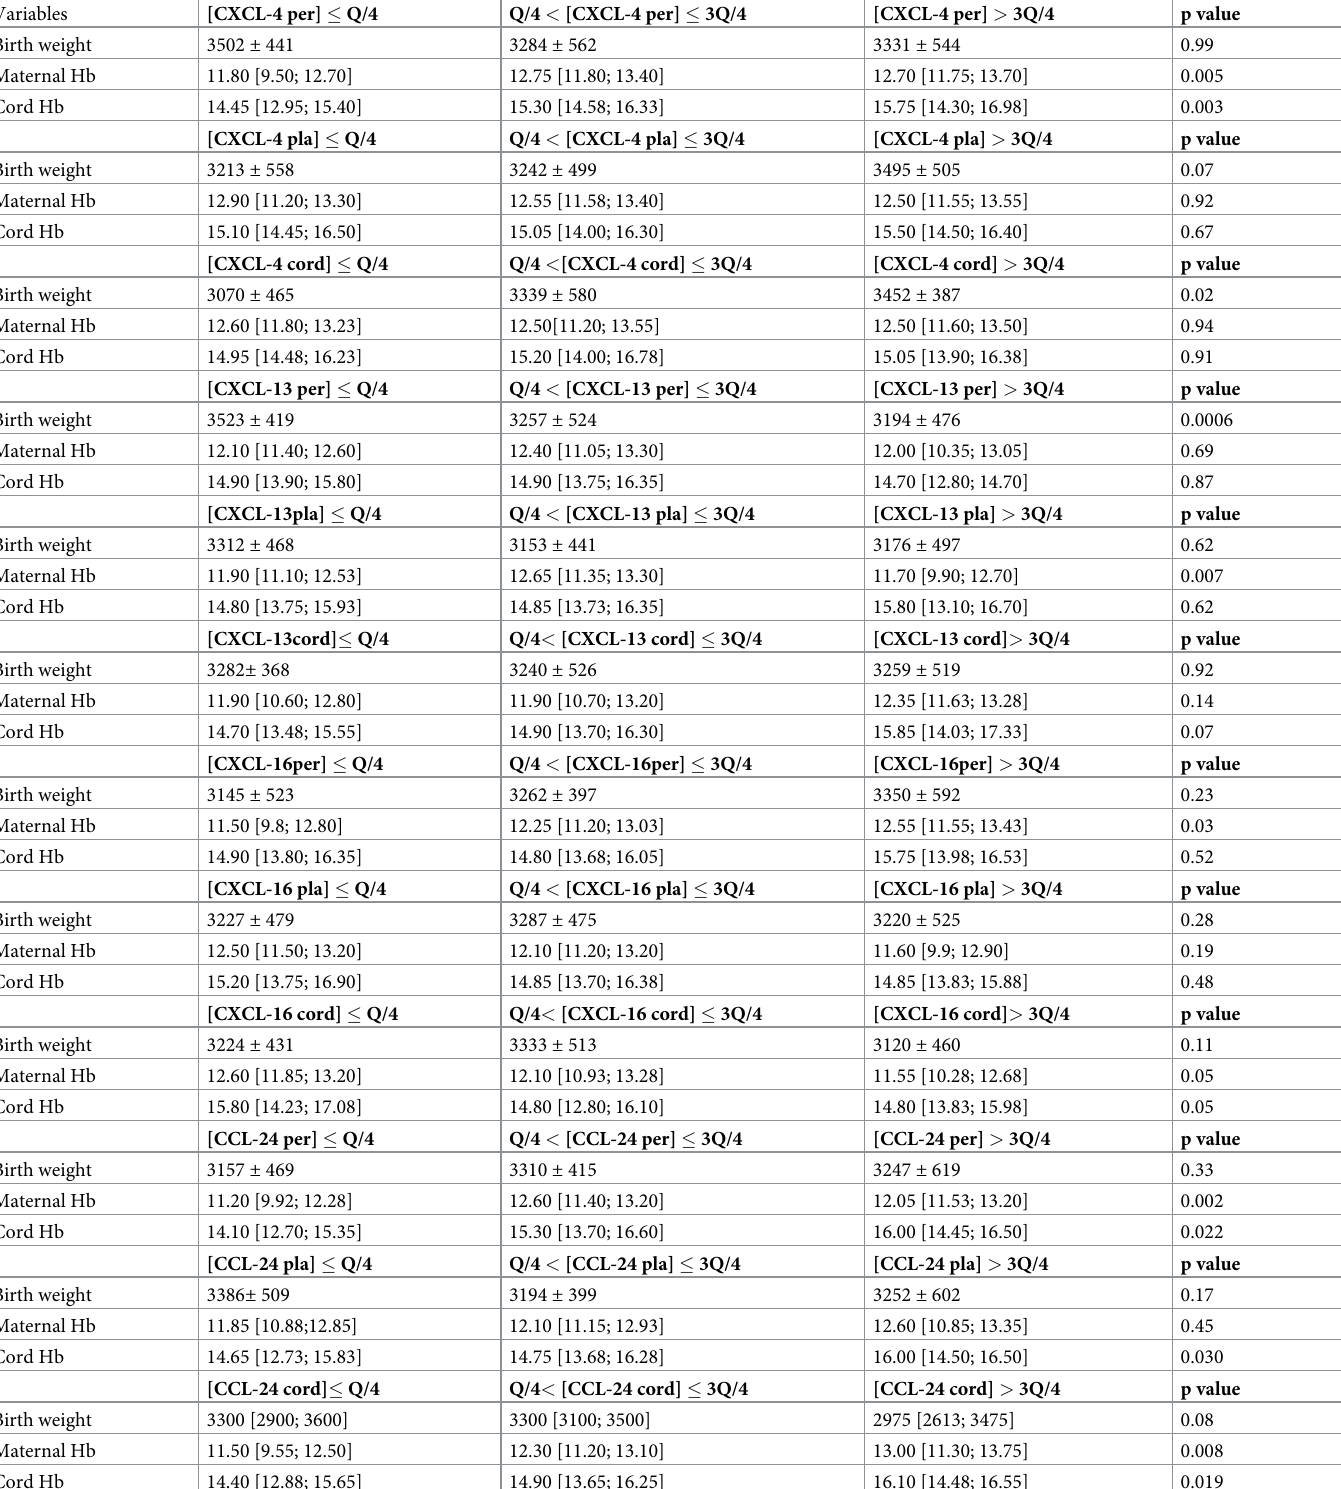
Table 2. Plasma levels of chemokines in relation to birth weight, maternal hemoglobin and foetal haemoglobin levels.